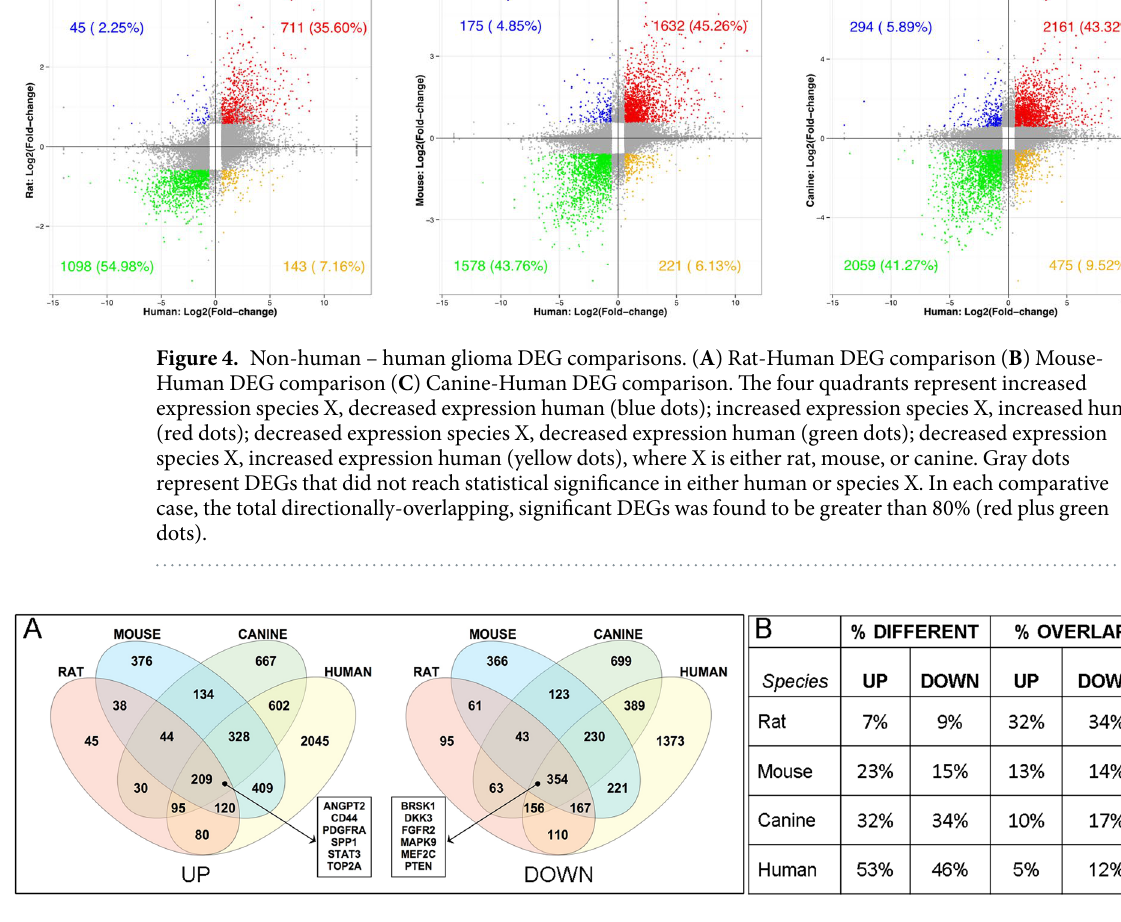
Figure 5. Four-species DEG Venn diagrams and data summary table. ( A ) Relative overlap of increased (UP) and decreased (DOWN) differentially expressed genes in rat, mouse, canine and human PDGFRA- overexpressing glioma. Six examples of commonly up-regulated or down-regulated DEGs are listed in the boxes. ( B ) The unique and overlapping DEGs were compared by calculating the percentage of unique DEGs in the total DEG set for that species (% different) and the percentage of the common glioma DEGs represented within the total DEG set for that species (% overlap). The rat tumors showed the smallest percentage of unique DEGs, and the largest percent overlap of the common DEGs within the total rat DEG set. The human and canine tumors showed the greatest percentage of unique DEGs and lowest percent overlap of the common